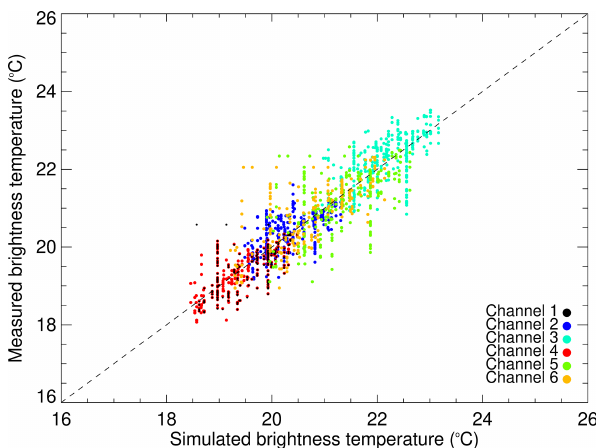
Figure 7. Correlation between the cloud-free simulations and the maximum brightness temperature values displayed in Fig. 6, which represent cloud-free measurements over the warm